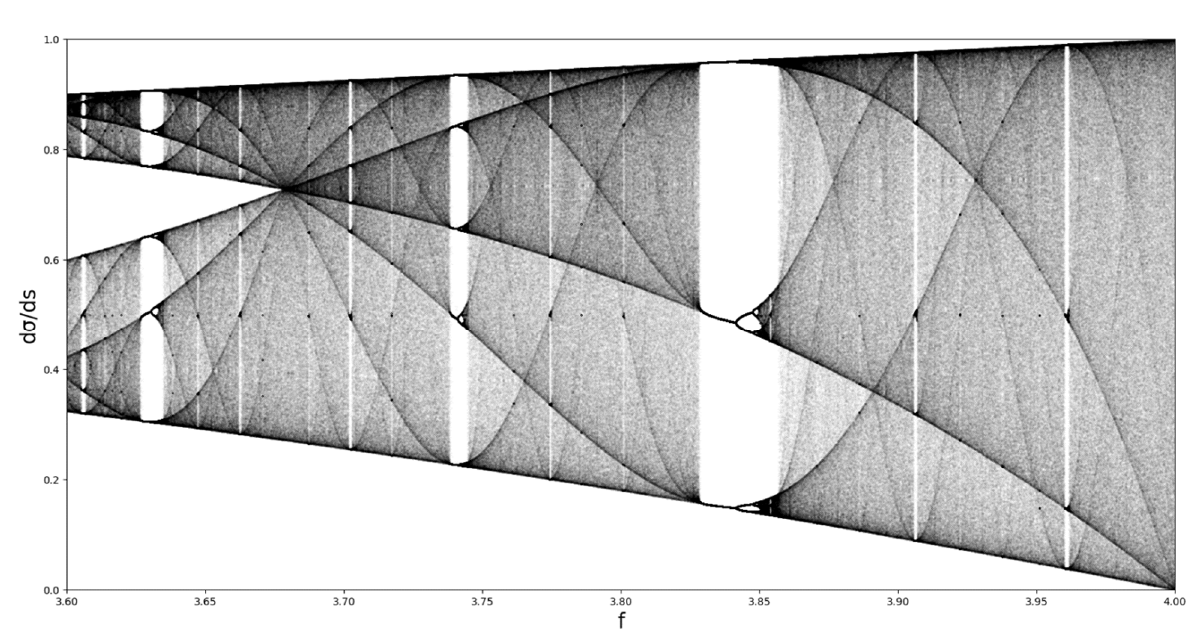
Figure 7. Representation of Equation (35) in the same manner as the logistic map; chaotic region with areas of stability.